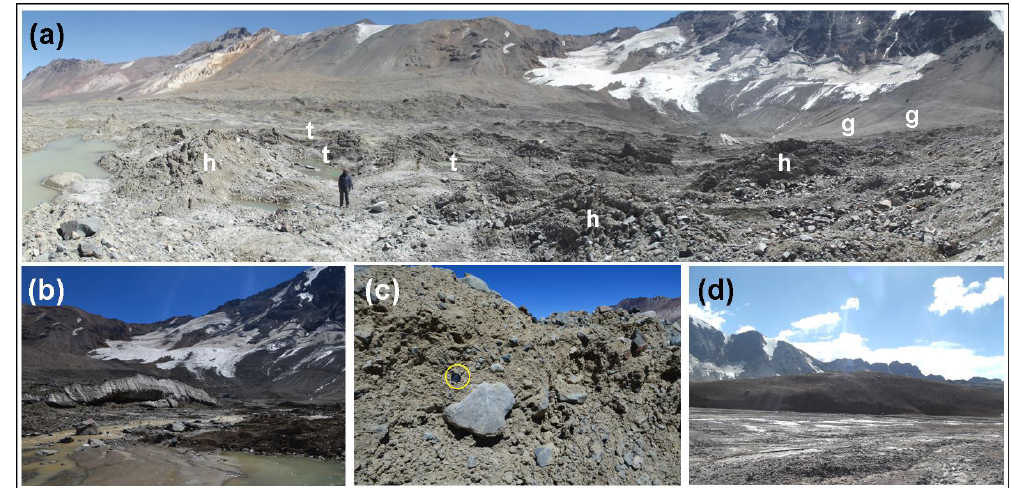
Figure 3. (a) Panoramic view of the Leñas Glacier and avalanche deposit in March 2018, showing the chaotic arrangement of thermokarst ponds (t) and hummocks (h), and the glacier head on the far upper right. The failed glacier area lies below the debris-free ice. Note the absence of rock outcrops/hard bed in the failed glacier area and the deeply incised gullies (g) in the sediment layer. (b) Former glacier fragment at the base of the detachment area. (c) Detail of the debris cover on the avalanche deposit, showing the rock fragments and matrix (see the black camera objective cover inside the yellow circle for scale). (d) Presumably ice-cored LIA moraines. Photos (b) and (c) courtesy of Mariana